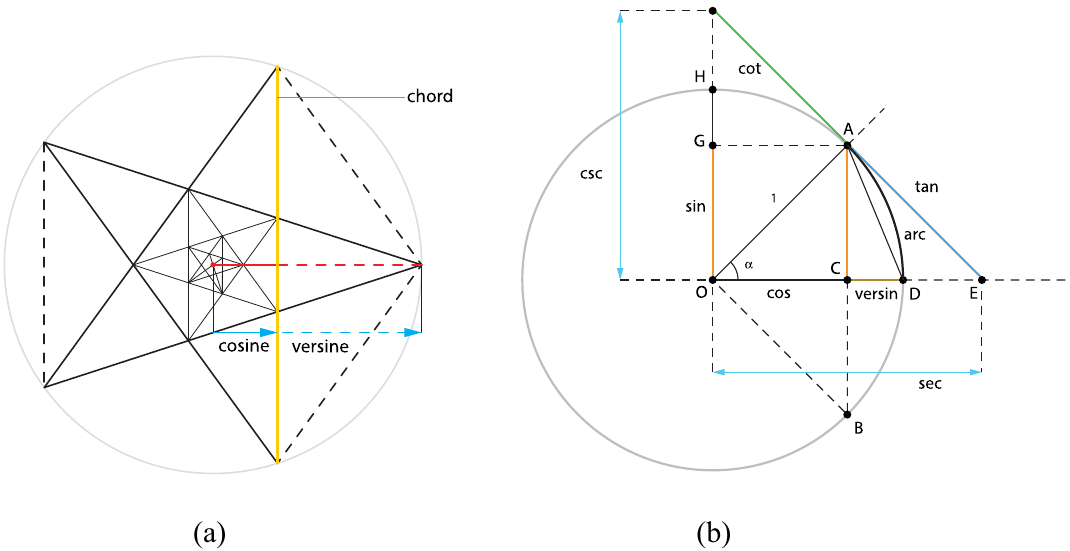
Figure 14. (a) Radial (red, dotted + solid) and chordal (yellow) knives. (b) Classical trigonometric